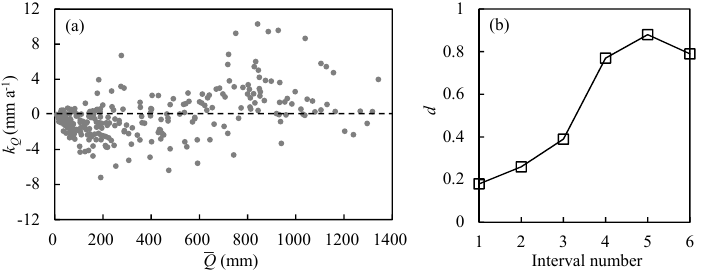
Figure 4. (a) Relationship between observed runoff trends k Q and mean annual runoff Q for the study catchments during the period 1956– 2000. (b) Values of d in each interval according to Q . d denotes the proportion of catchments with positive trends in each interval. Interval